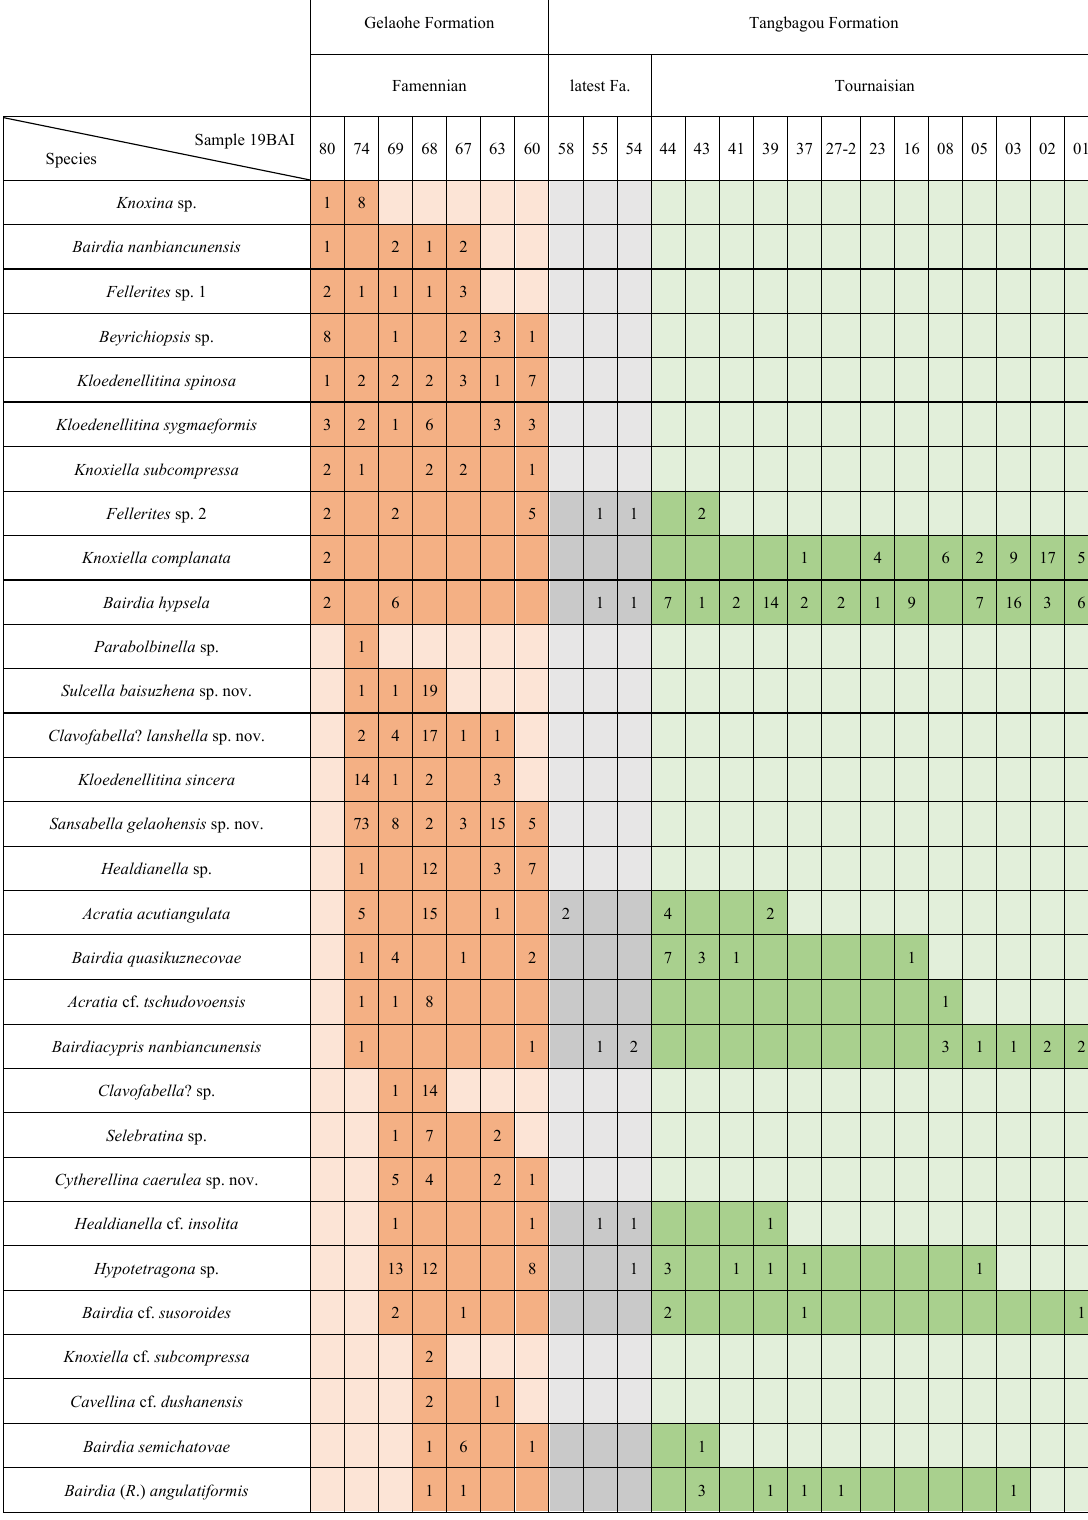
Orange: Association A, Grey: Association B, Green: Association C